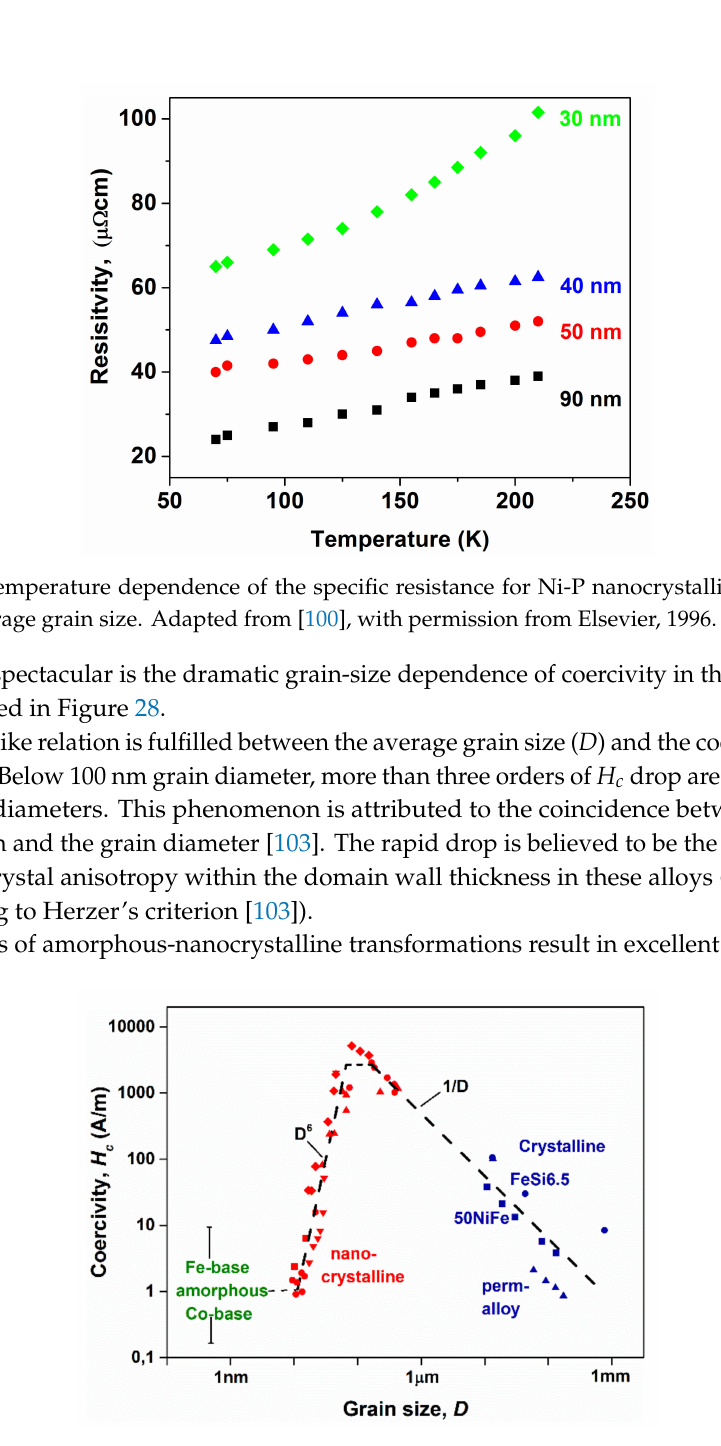
Figure 28. The change of coercivity ( H c ) versus the average grain size ( D ) in several crystalline alloys. Adopted from [103], with permission from Elsevier,